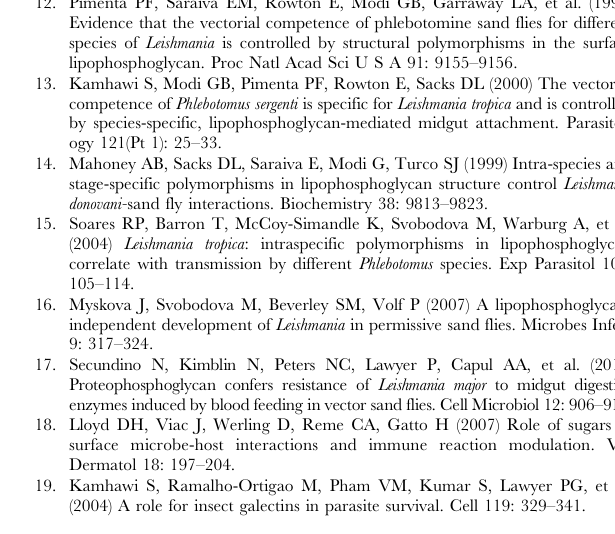
Figure S1 Survival of natural and isogenic lines of L. major in P. duboscqi , the natural vector of L. major in West Africa, is